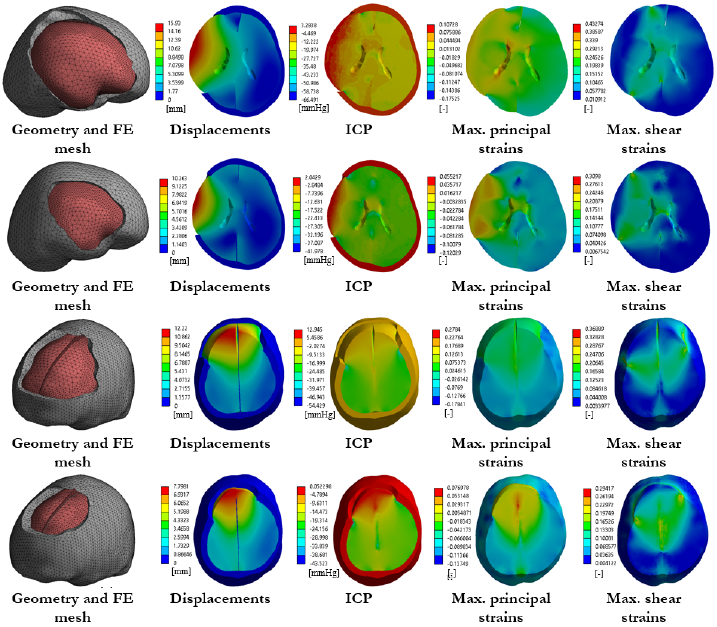
Figure 4. Geometry and FE results in case of different DC scenarios.